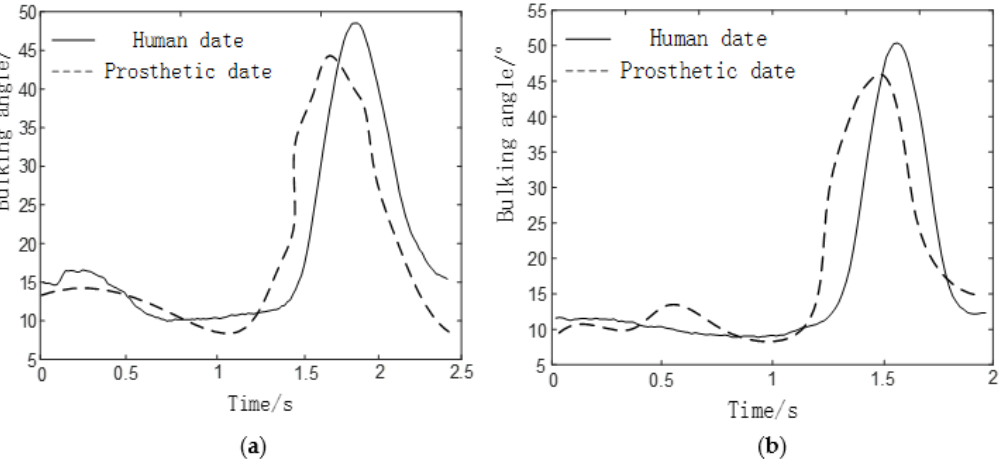
Figure 18. Comparison of knee and ankle prosthesis data and human data. ( a ) Changes in knee angle on uphill knees. ( b ) Changes in knee angle on downhill knees.